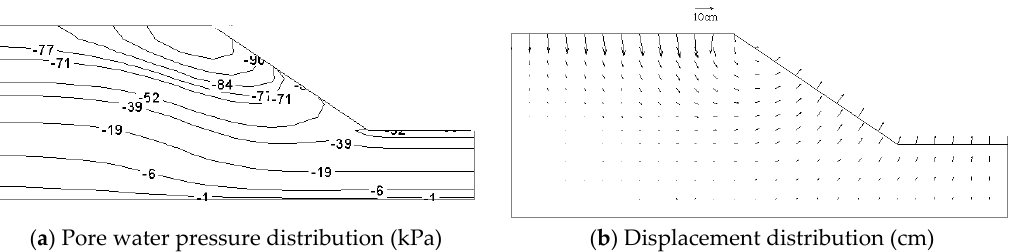
Figure 3. The distributions of pore water pressure and displacement at the end of rainfall.